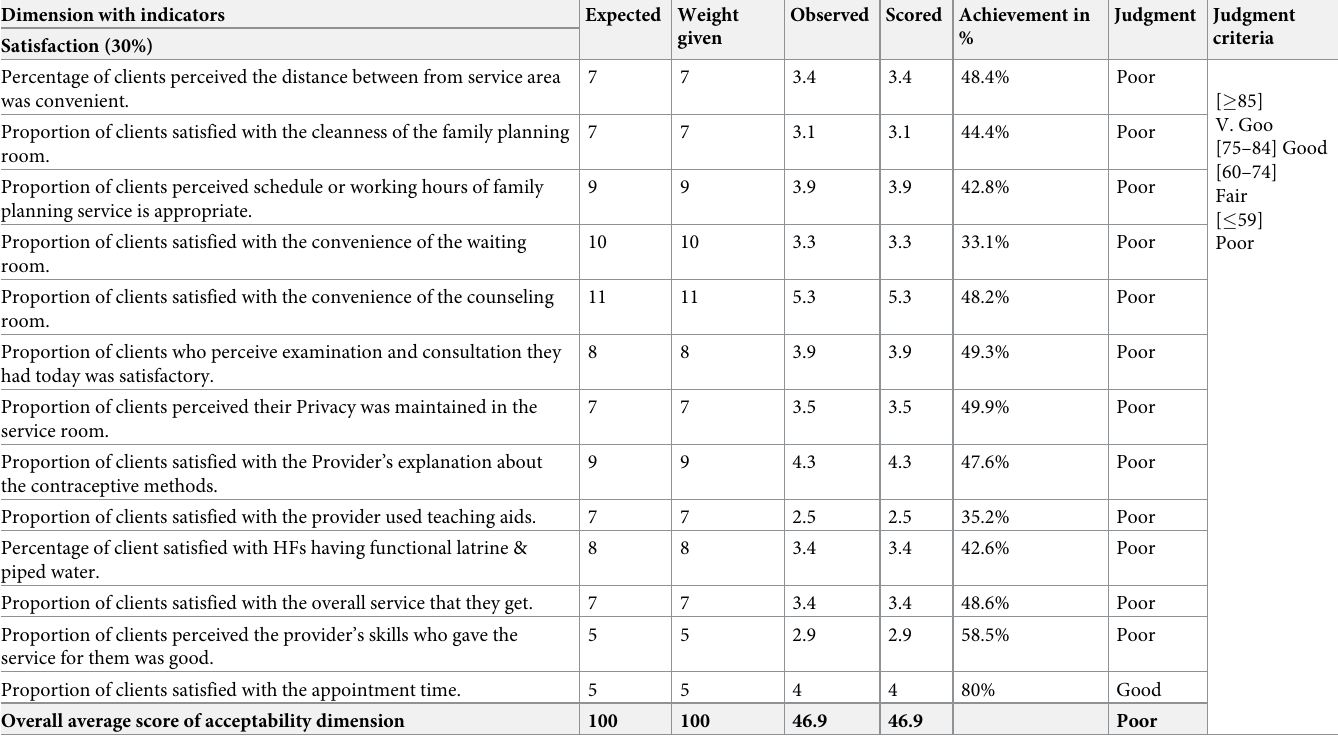
Table 5. Judgment matrix of acceptability (satisfaction) dimension of family planning service in Gondar city administrative public health facilities, Northwest Ethi- opia, 2020. Dimension with